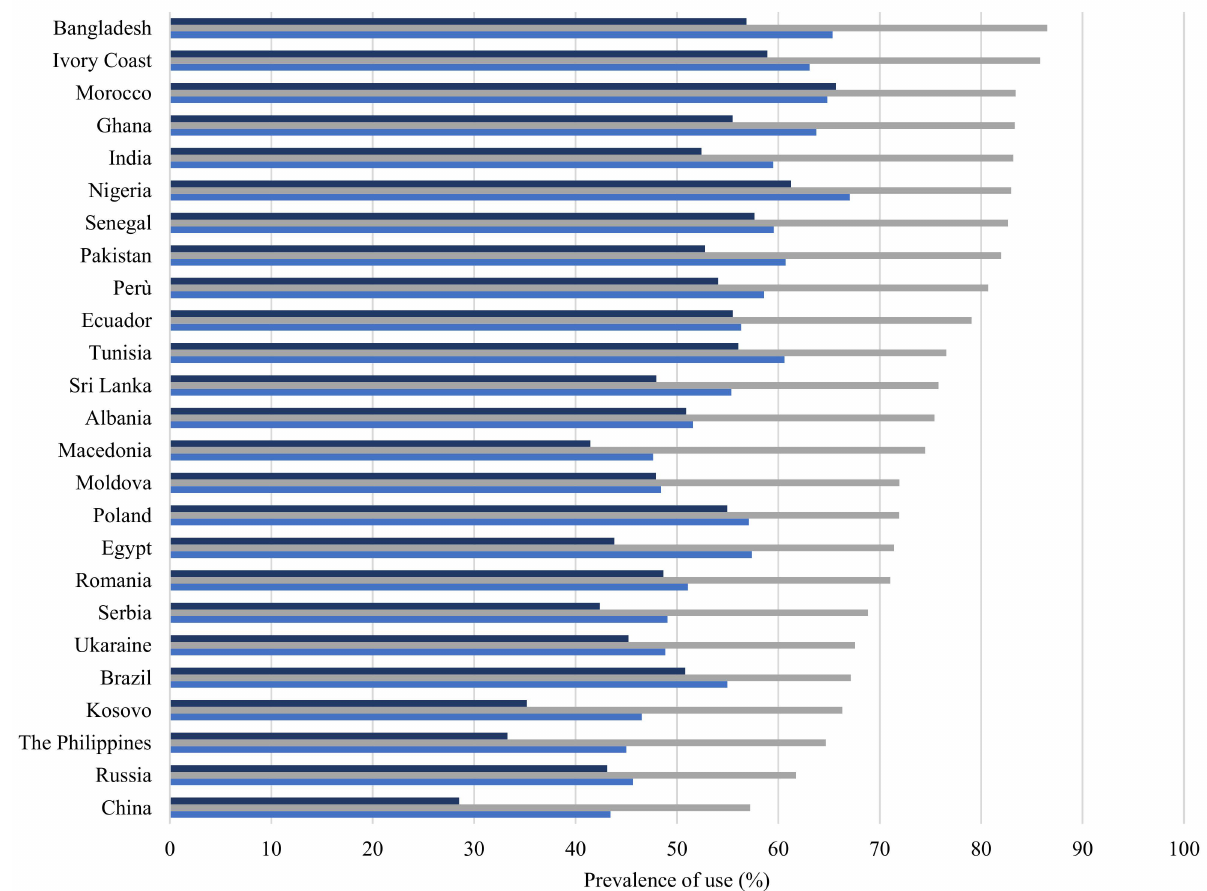
Figure 2. Distribution of drug prescriptions (%) before, during and after pregnancy, by citizenship (top 25 countries by number of